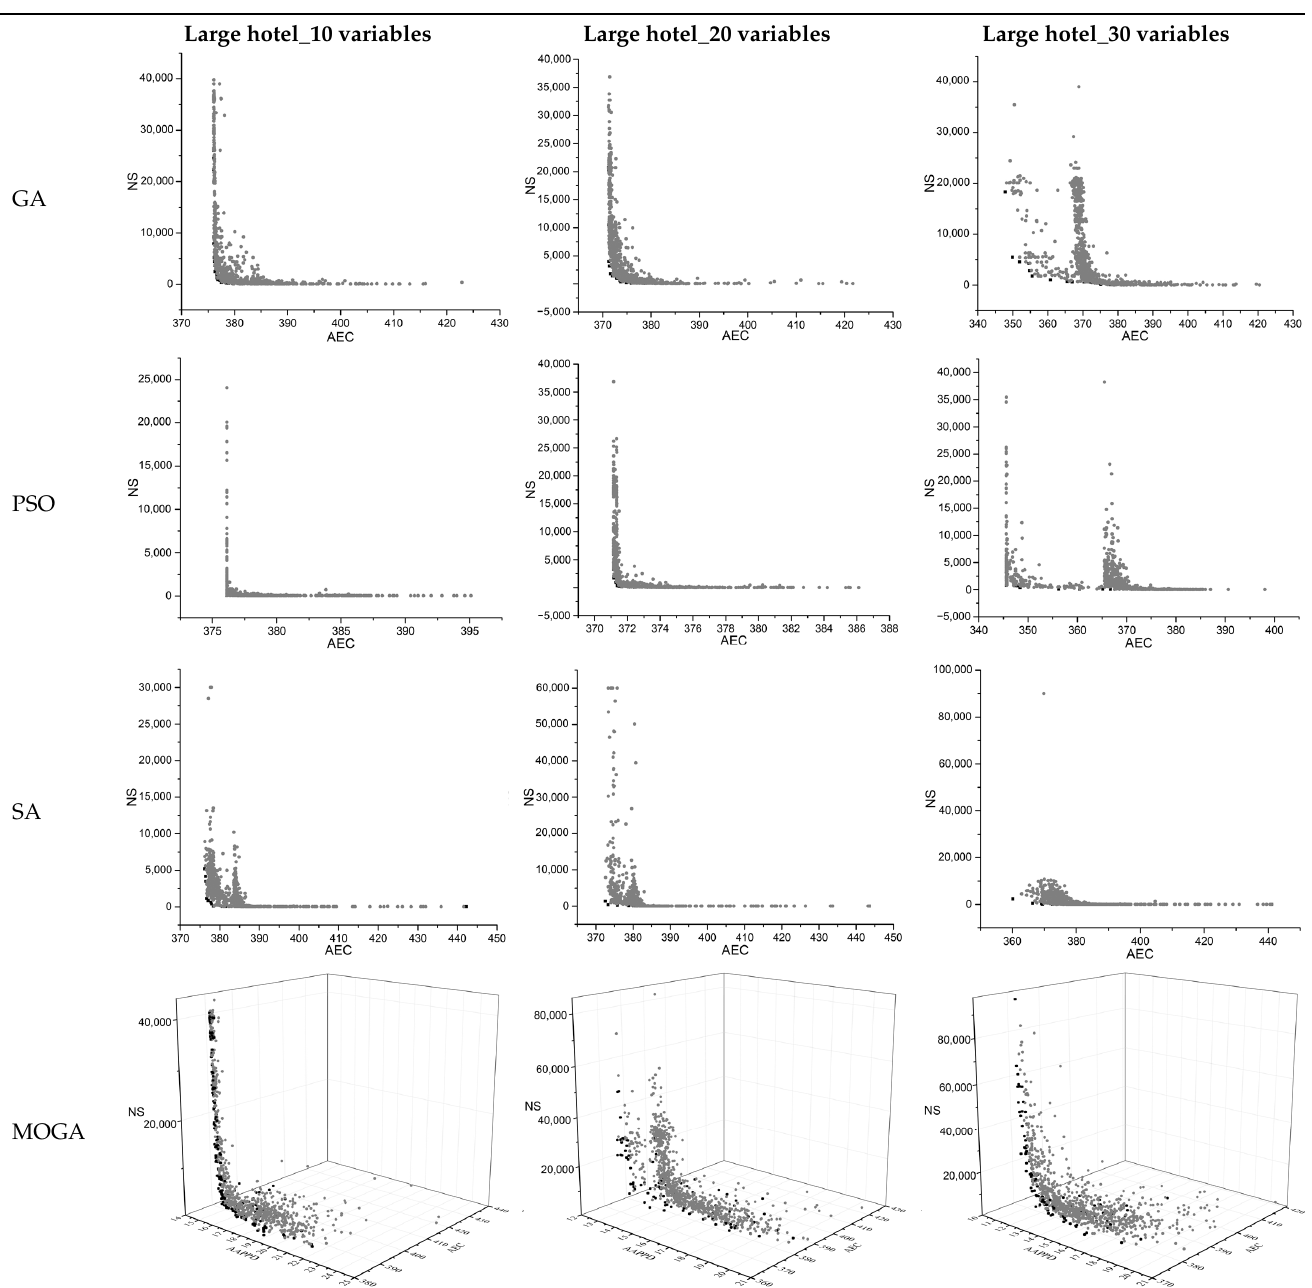
The black dots are non-dominant solutions, and the gray dots are dominant The black dots are non ‐ dominant solutions, and the gray dots are dominant solutions. The black dots are non ‐ dominant solutions, and the gray dots are dominant solutions. The black dots are non ‐ dominant solutions, and the gray dots are dominant solutions. The black dots are non ‐ dominant solutions, and the gray dots are dominant solutions. The black dots are non ‐ dominant solutions, and the gray dots are dominant solutions. The black dots are non ‐ dominant solutions, and the gray dots are dominant solutions. The black dots are non ‐ dominant solutions, and the gray dots are dominant solutions. The black dots are non ‐ dominant solutions, and the gray dots are dominant solutions. The black dots are non ‐ dominant solutions, and the gray dots are dominant solutions.